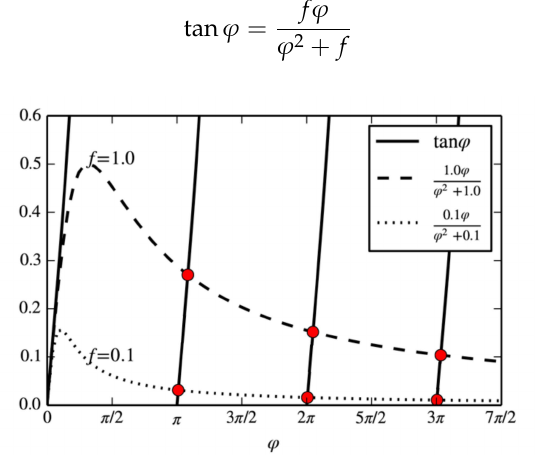
Figure 1. Graphical representation of the characteristic Equation (11). The solid lines represent the tangent function of φ and the dotted lines represent the fraction with di ff erent values of the non-dimensional number f . The red circles represent the characteristic roots of Equation (11). As f decreases, each characteristic root tends to be a positive integer multiple of π